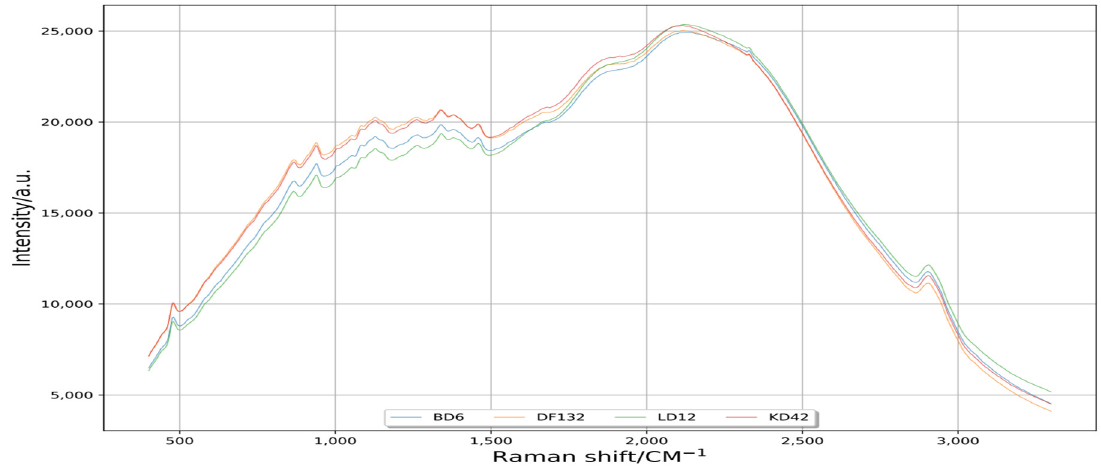
Figure 2. Original spectral curve. Raman shift is the reciprocal of wavelength, unrelated to the frequency of incident light and only related to the vibration frequency of sample molecules, and its range is 200–3400 cm − 1 . Intensity is the intensity of Raman scattering, which is the anti-Stokes line; the anti-Stokes line is the scattering light of frequency shifted light from monochromatic incident light in a molecule.